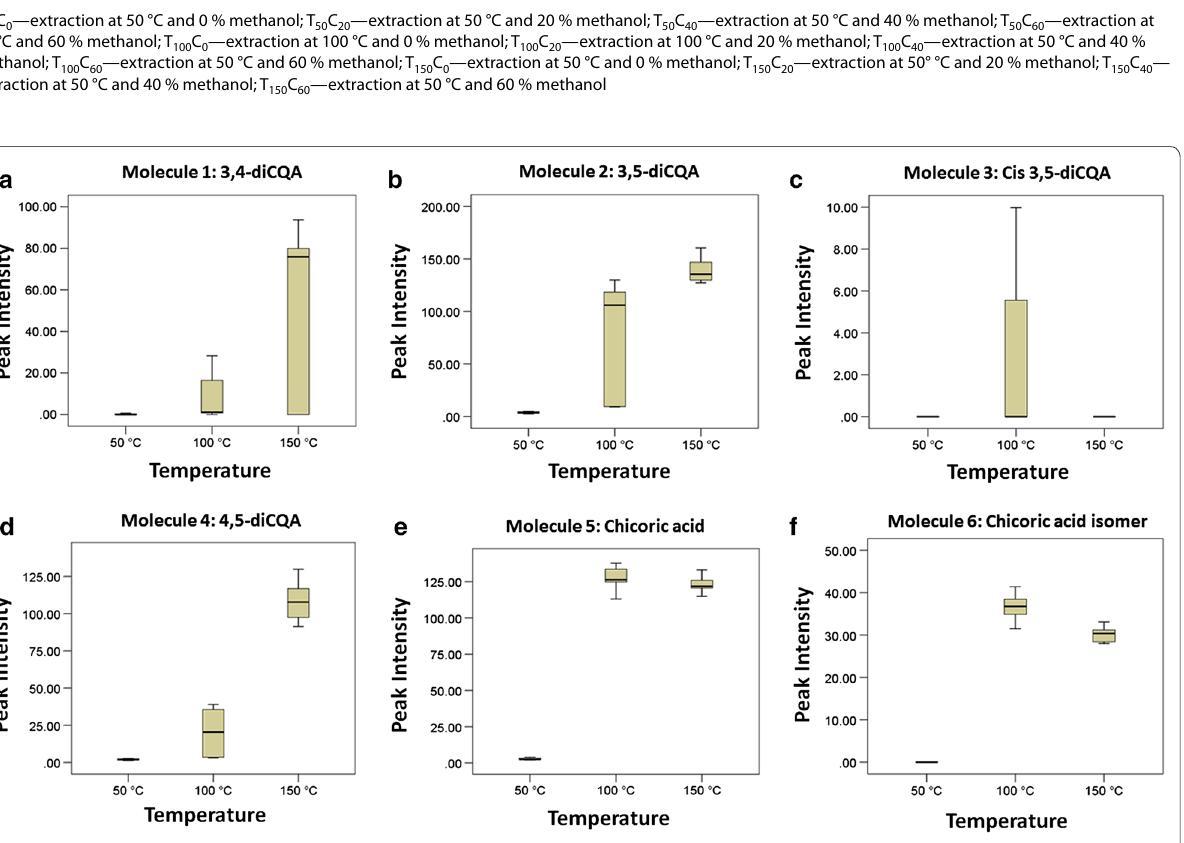
Fig. 3 Box -and- whiskers plots showing the effect of temperature on the extractability of isomers of diCQA and CA using water-only PHWE: 3,4- diCQA ( a ), 3,5-diCQA ( b ), Cis -3,5-diCQA ( c ), 4,5-diCQA ( d ), CA ( e ) and CA isomer ( f